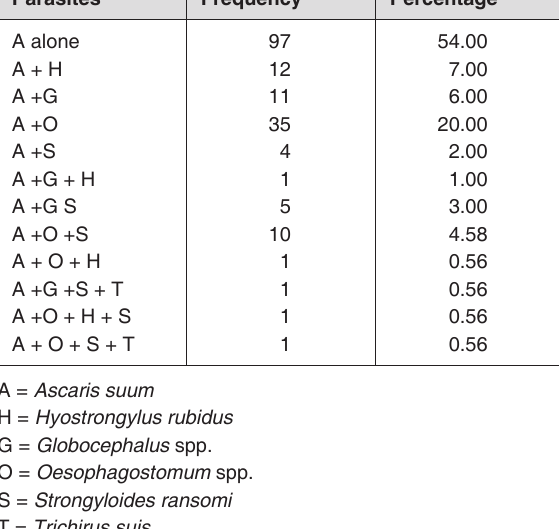
TABLE 3 Occurrence and association of Ascaris suum with oth- er nematode parasites in scavenging pigs (383) in the Eastern Centre Province, Burkina Faso